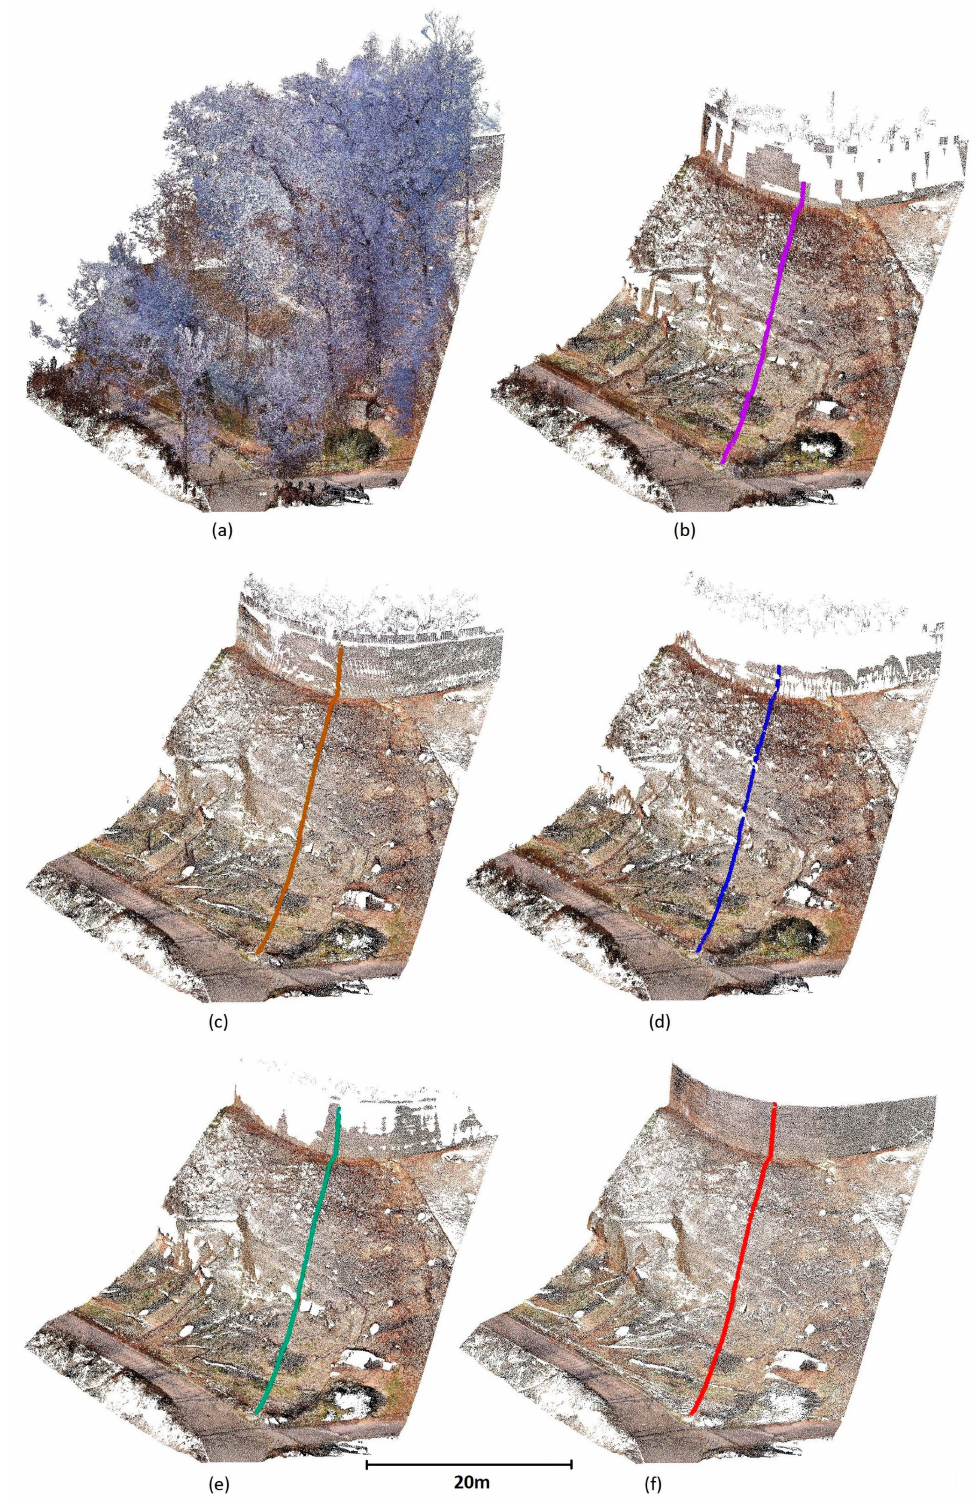
Figure 9. Site 3: ( a ) original, ( b ) after PMF filtering, ( c ) after SMRF filtering, ( d ) after CSF filtering, ( e ) after ATIN filtering, and ( f ) after MDSR filtering. The profiles show similar results as for previous sites, but in this case, the differences are even greater (Figure